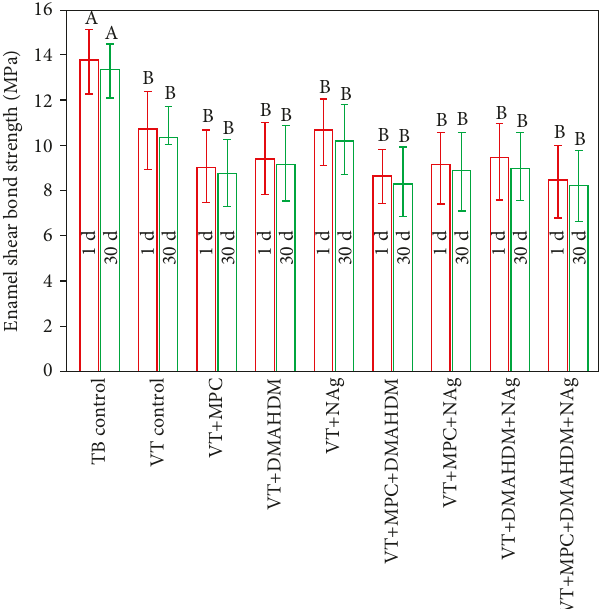
Figure 1: Enamel shear bond strengths (SBS) ( mean ± sd ; n = 10 ). Incorporating 3% MPC+1.5% DMAHDM+0.1% NAg into VT did not adversely a ff ect the SBS, compared to VT control ( p > 0 1 ). Water aging for 30d had no signi fi cant e ff ect on SBS, compared to those at 1d ( p > 0 1 ). Bars with dissimilar letters indicate values that are signi fi cantly di ff erent from each other ( p < 0 05 ). (Adapted from reference [38], with